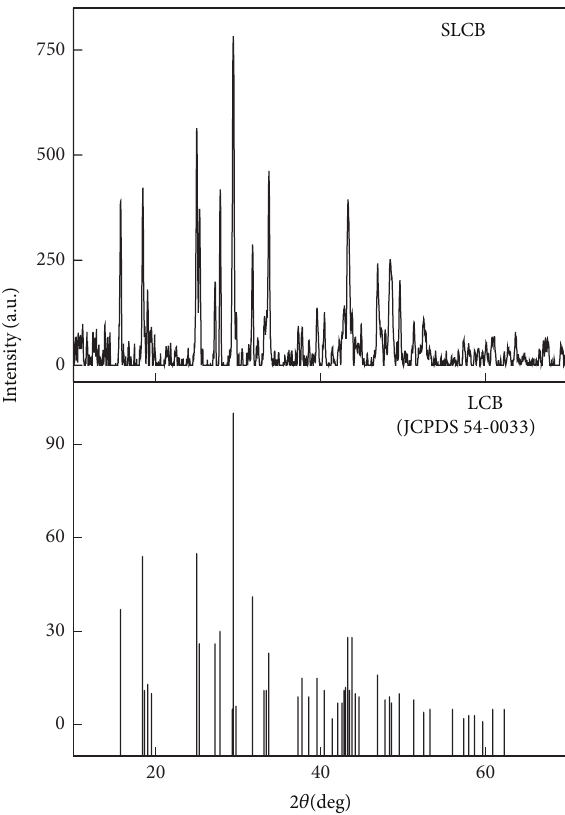
Figure 1: X-ray diffraction patterns of SLCB phosphor and the referenced LCB (JCPDS number 54-0033).